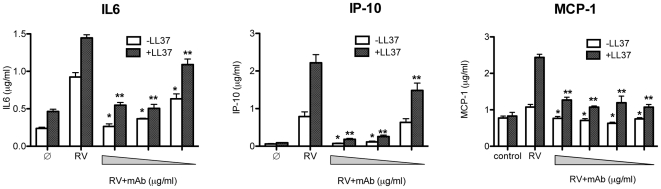
LL37 can enhance the cytokine response to Rhinovirus (RV) infection in cultured BEAS2B cells.LL37 was present at a final concentration of 3 µM and cytokine levels determined using a Milliplex cytokine/chemokine kit. The symbol ∅ denotes mock-infected cells. LL37 enhanced cytokine production in RV infected cells and the effects were blocked by increasing concentrations of a monoclonal antibody specific to TLR3 (denoted by the grey triangle; [40]). * Indicates p<0.05 compared to cytokine levels in RV infected cells while ** indicates p<0.05 compared to cytokine levels induced by addition of LL37 to RV infected cells. Each bar shows mean (±SEM; n = 3).